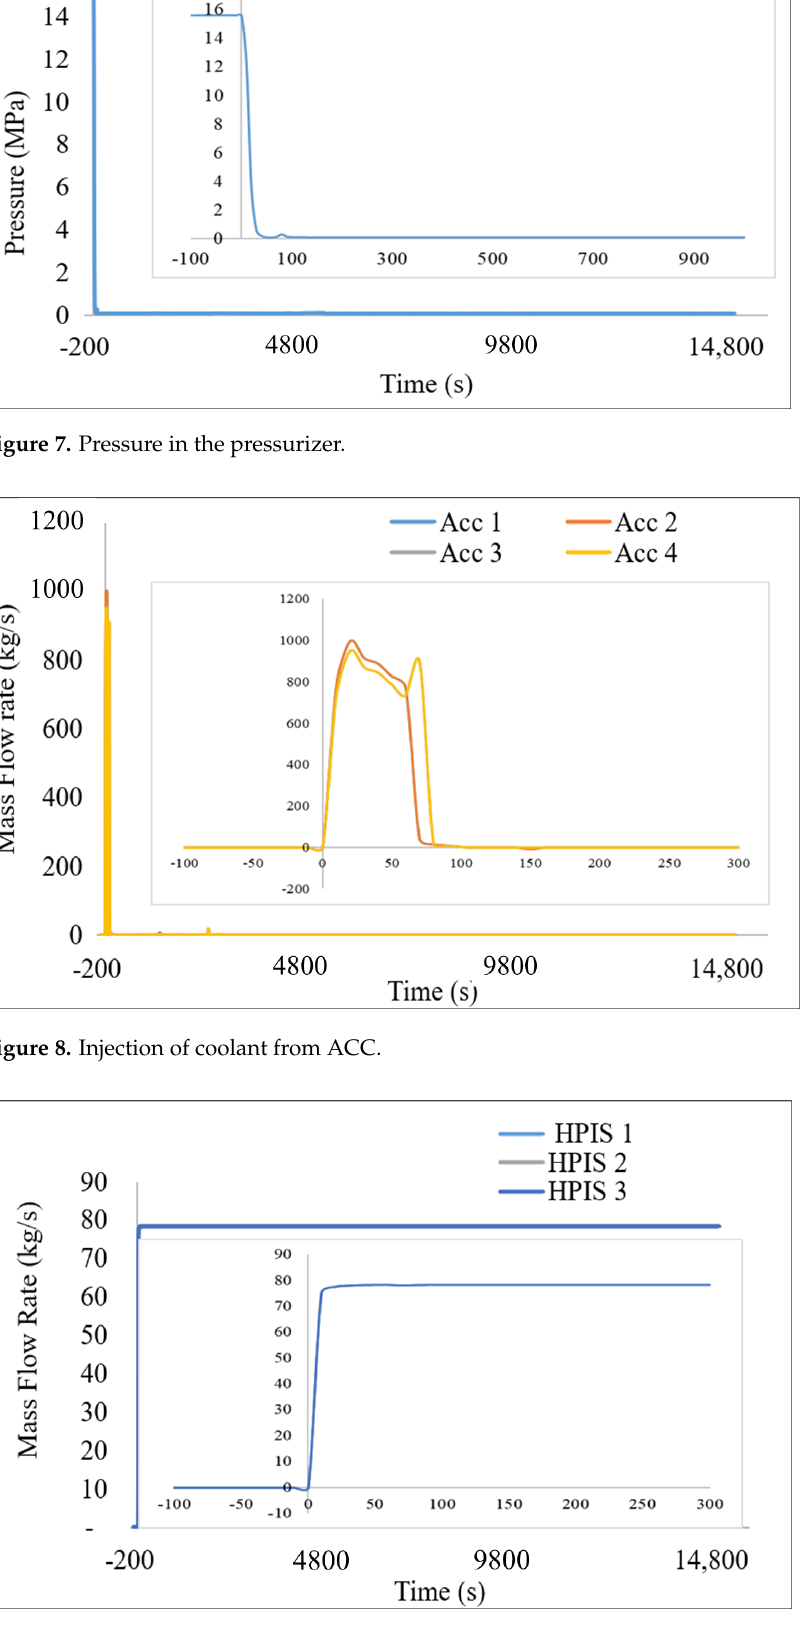
Figure 9. Injection of coolant from HPIS.